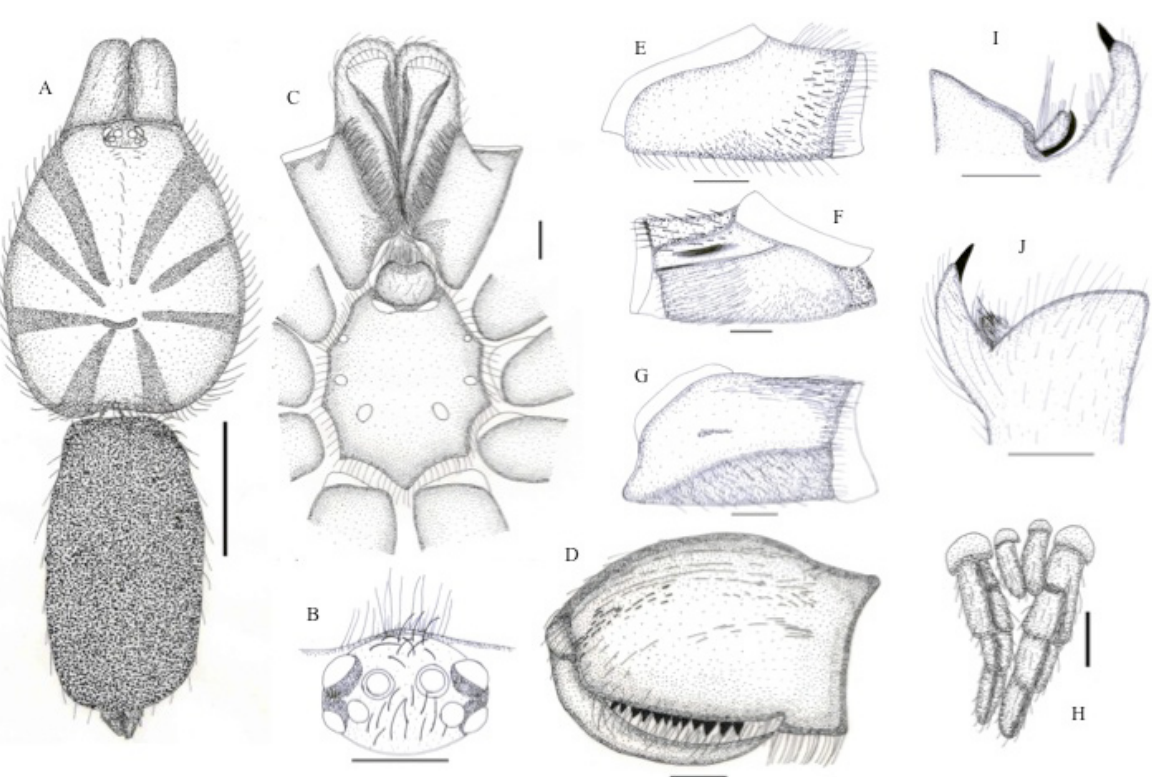
Figure 2. Neoheterophrictus crurofulvus sp. nov., male (WILD-09-ARA-472). A - Carapace and abdomen dorsal view; B - Eye; C - Sternum, maxillae, labium, chelicerae; D - Chelicerae prolateral view; E - Maxillae, retrolateral view; F - Coxa I, prolateral view; G - Coxa I, retrolateral view; H - Spinnerets; I - Tibial spur, prolateral view; J - Tibial spur, retrolateral view. Scale 1.0mm for B–J and scale 0.5mm for